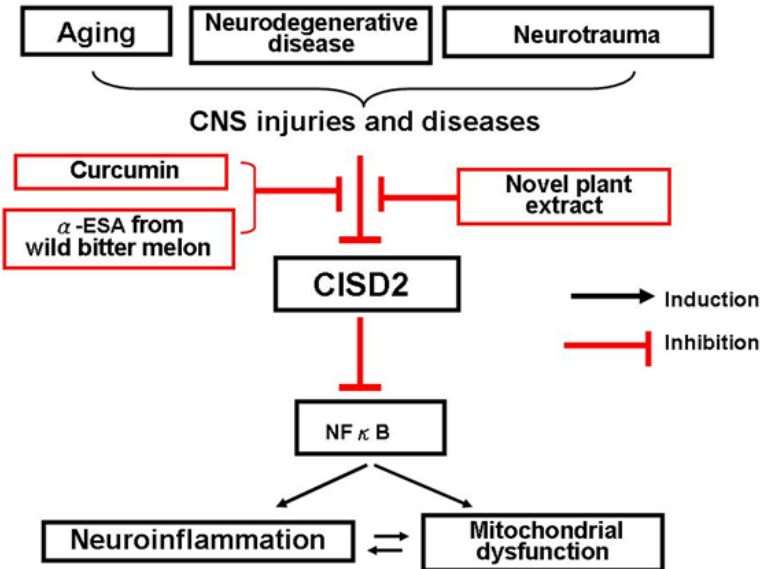
Figure 1. Diagram of CNS pathology–CISD2-NFκB axis. CDGSH iron-sulfur domain 2